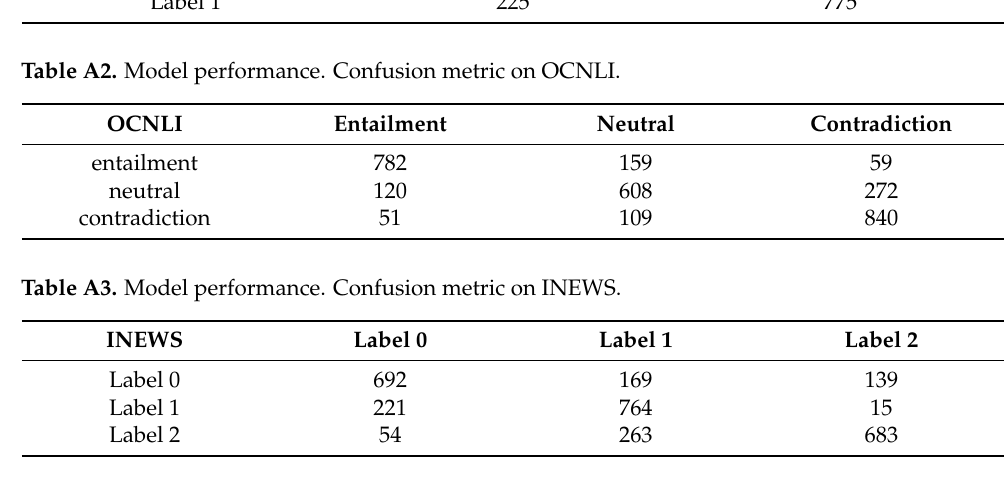
Table A4. Model performance. Confusion metric on BQ.